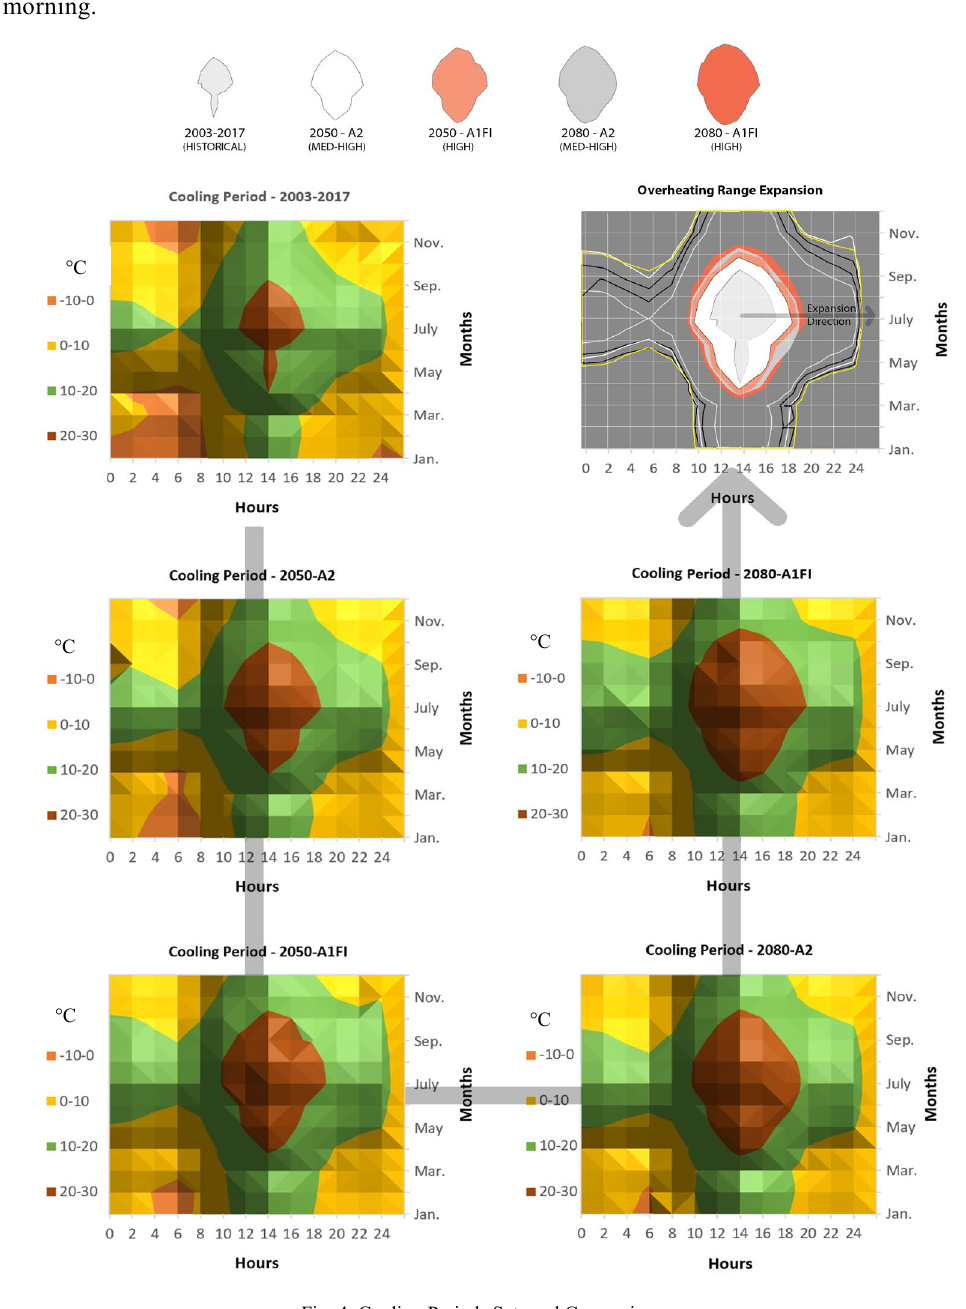
Fig. 4. Cooling Periods Sets and